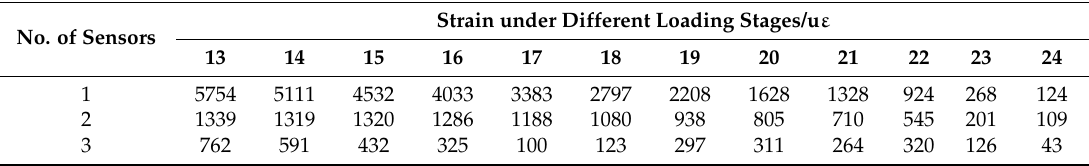
Table 6. Strain values of three FBG sensors in the unloading stage.